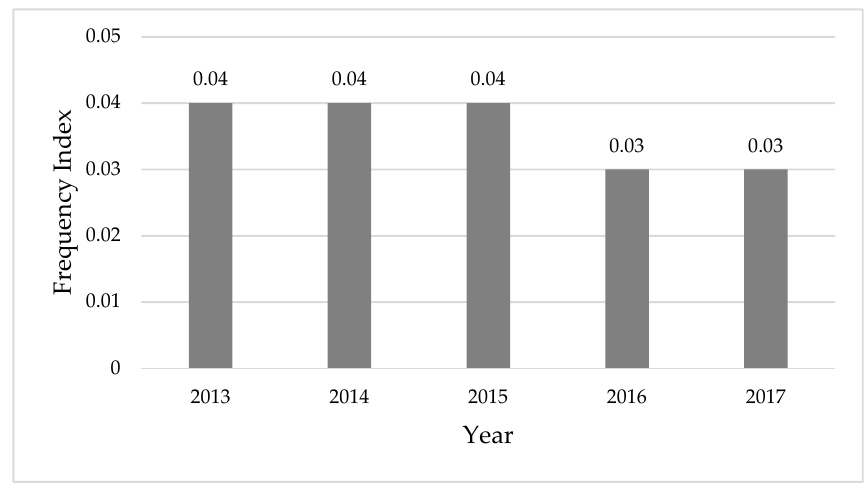
Figure 11. The frequency index of fatal accidents in Romania during 2013–2017 [2].